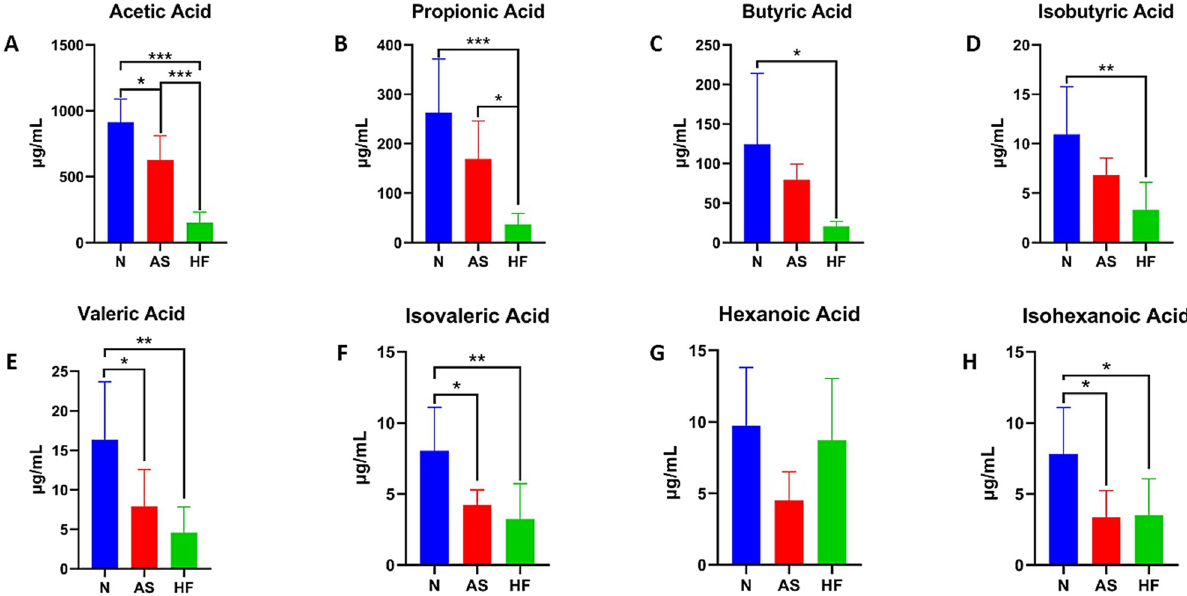
Fig 4. Analysis of short-chain fatty acid content in feces. A-H: Quantitative analysis of short-chain fatty acids in mouse feces.